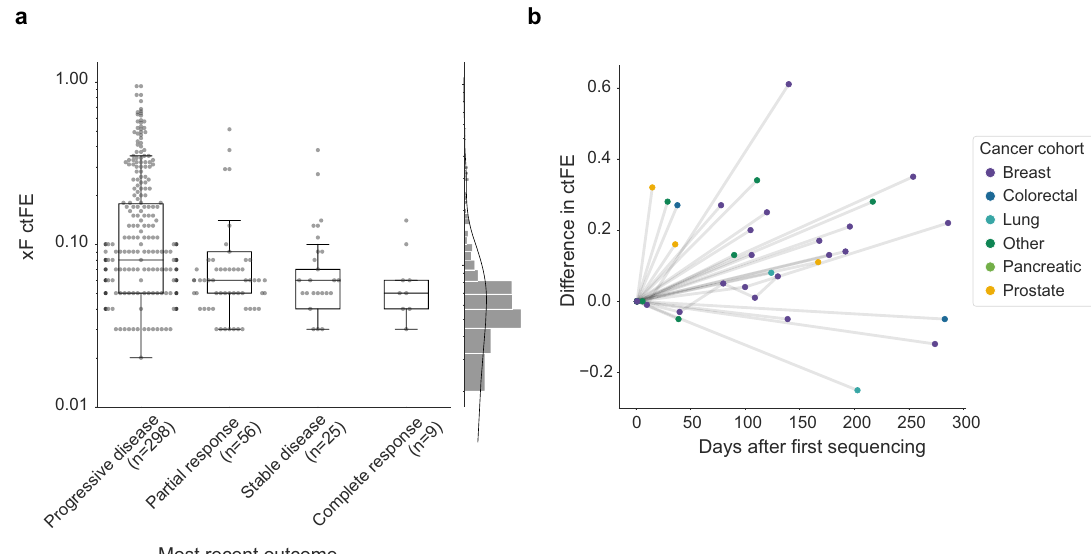
Fig. 5 Circulating tumor fraction estimate (cfTE) and abstracted clinical outcomes in a sub-cohort of the xF 1000 ( n = 388). a Patients with complete response ( n = 9, ctFE = 0.05) exhibited lower ctFEs than those with progressive disease ( n = 298, ctFE = 0.08), partial response ( n = 56, ctFE = 0.06), or stable disease ( n = 25, ctFE = 0.06). b ctFE was also assessed temporally among a few randomly selected patients with multiple xF tests throughout the course of treatment ( n = 26), with most patients showing large differences in ctFEs between test